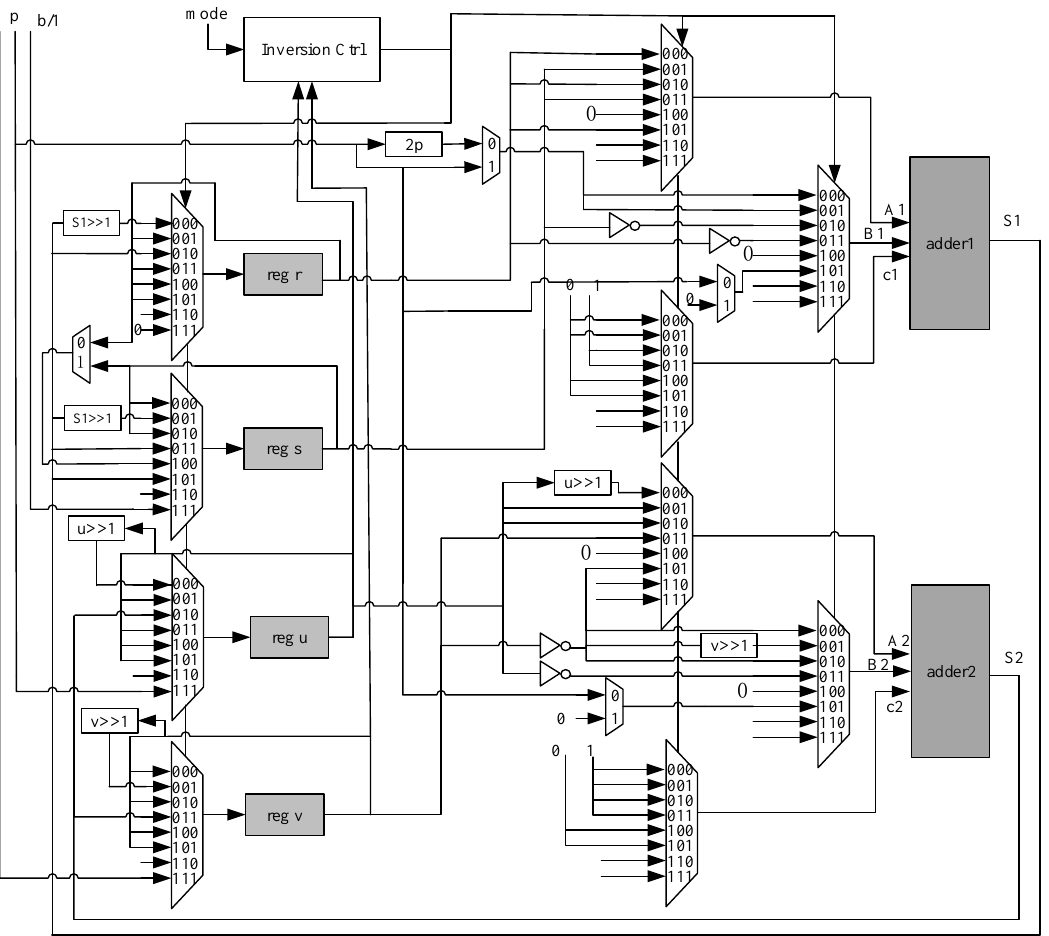
Figure 3. Inversion